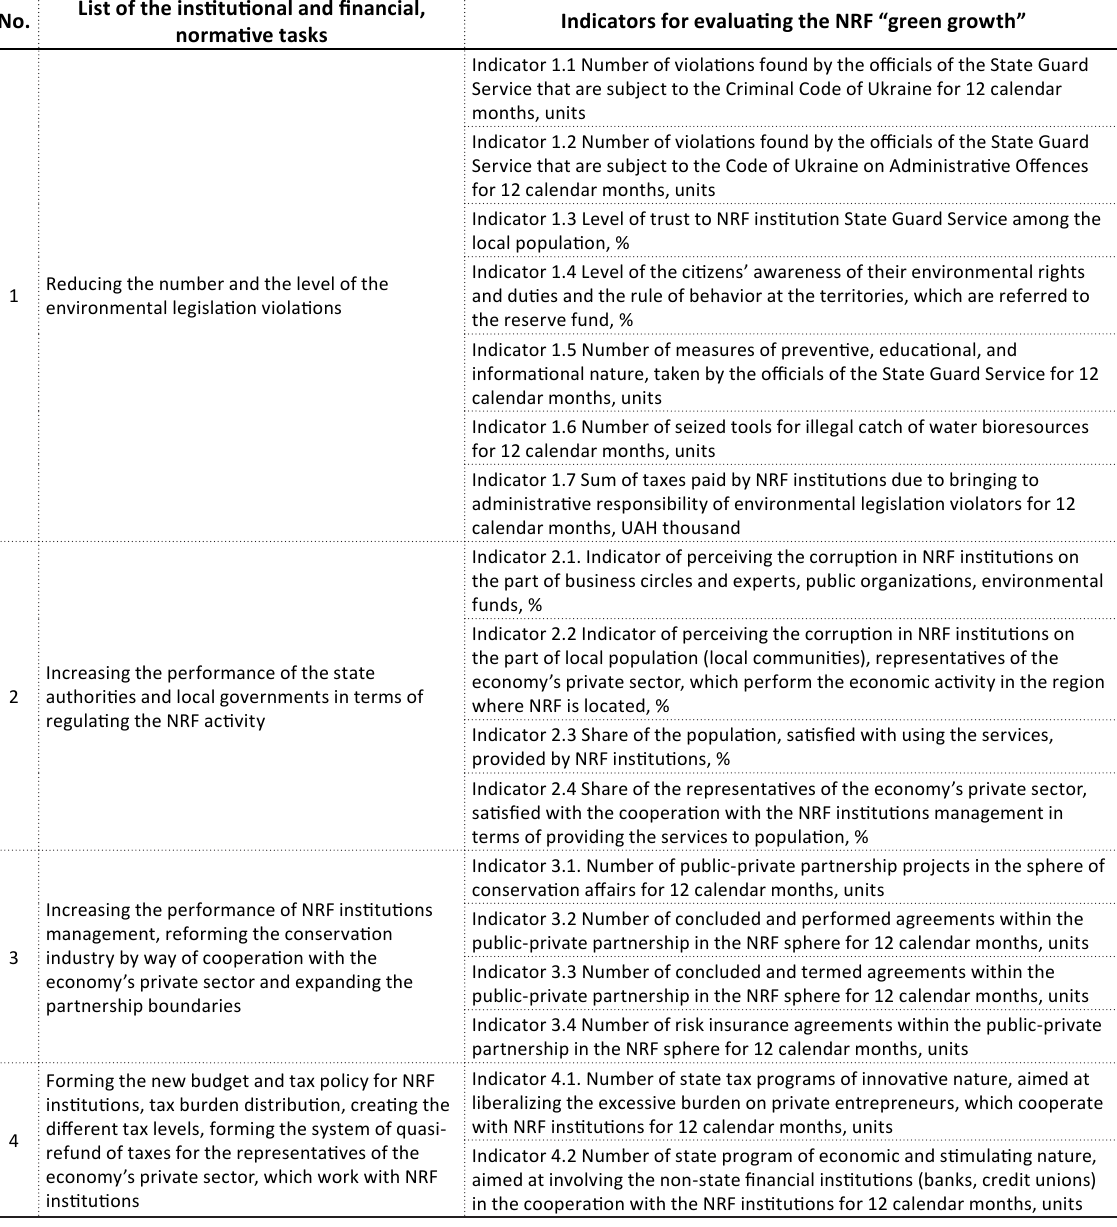
Table 1. Institutional and financial, normative tasks and indicators of the NRF “green growth” No. List of the institutional and